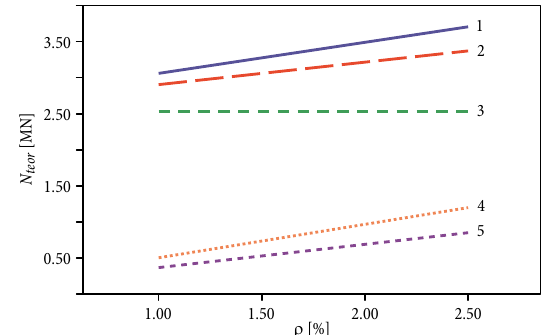
Fig. 6. The longitudinal reinforcement ratio ρ, the dependence on theoretical axial force N teor calculated by a different calculation algorithm by Eq. (7) [line – 1] and Eq. (6) [line – 2], where the carrying capacity of concrete N c [line – 3] and longitudinal reinforcement N f ( b ) [line – 4] and N f ( a ) [line – 5]